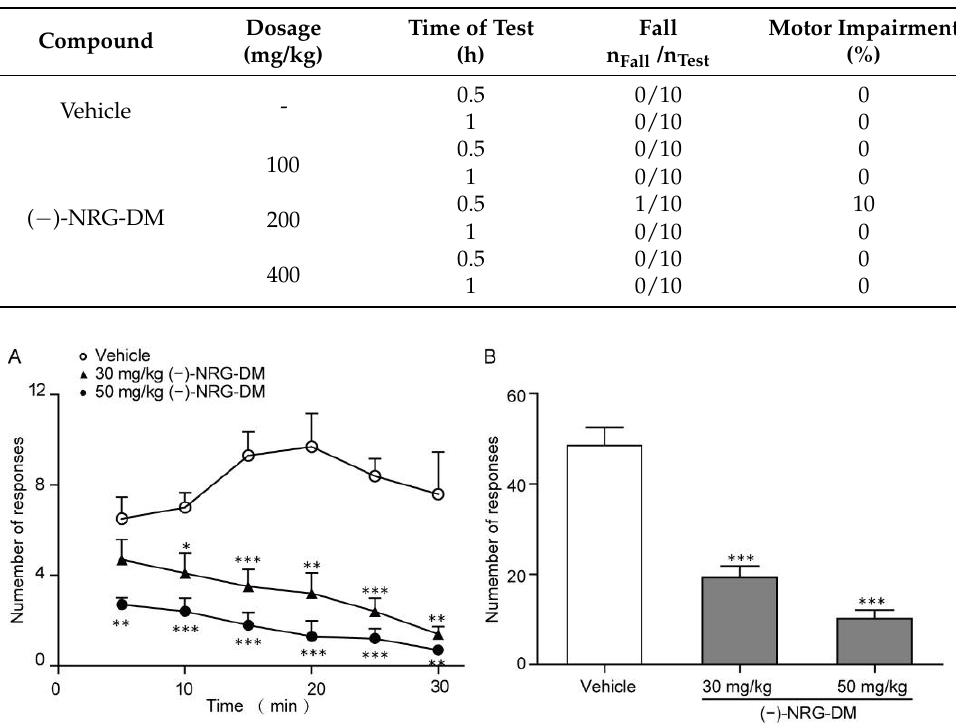
Figure 3. Analgesic effects of ( − )-NRG-DM in the mustard oil-induced mouse colorectal pain model. ( A ) 30 mg/kg and 50 mg/kg ( − )-NRG-DM attenuated the acute pain-related behaviors throughout the 30 min trial. ( B ) Bar graph showing the effects of vehicle (white), 30 mg/kg and 50 mg/kg ( − )-NRG-DM (grey) on the writhing number caused by pain during a 30 min period in the mustard oil-induced mouse colorectal pain model. In all groups, n = 10 animals. Statistical significance: * p ≤ 0.05, ** p ≤ 0.01, *** p ≤